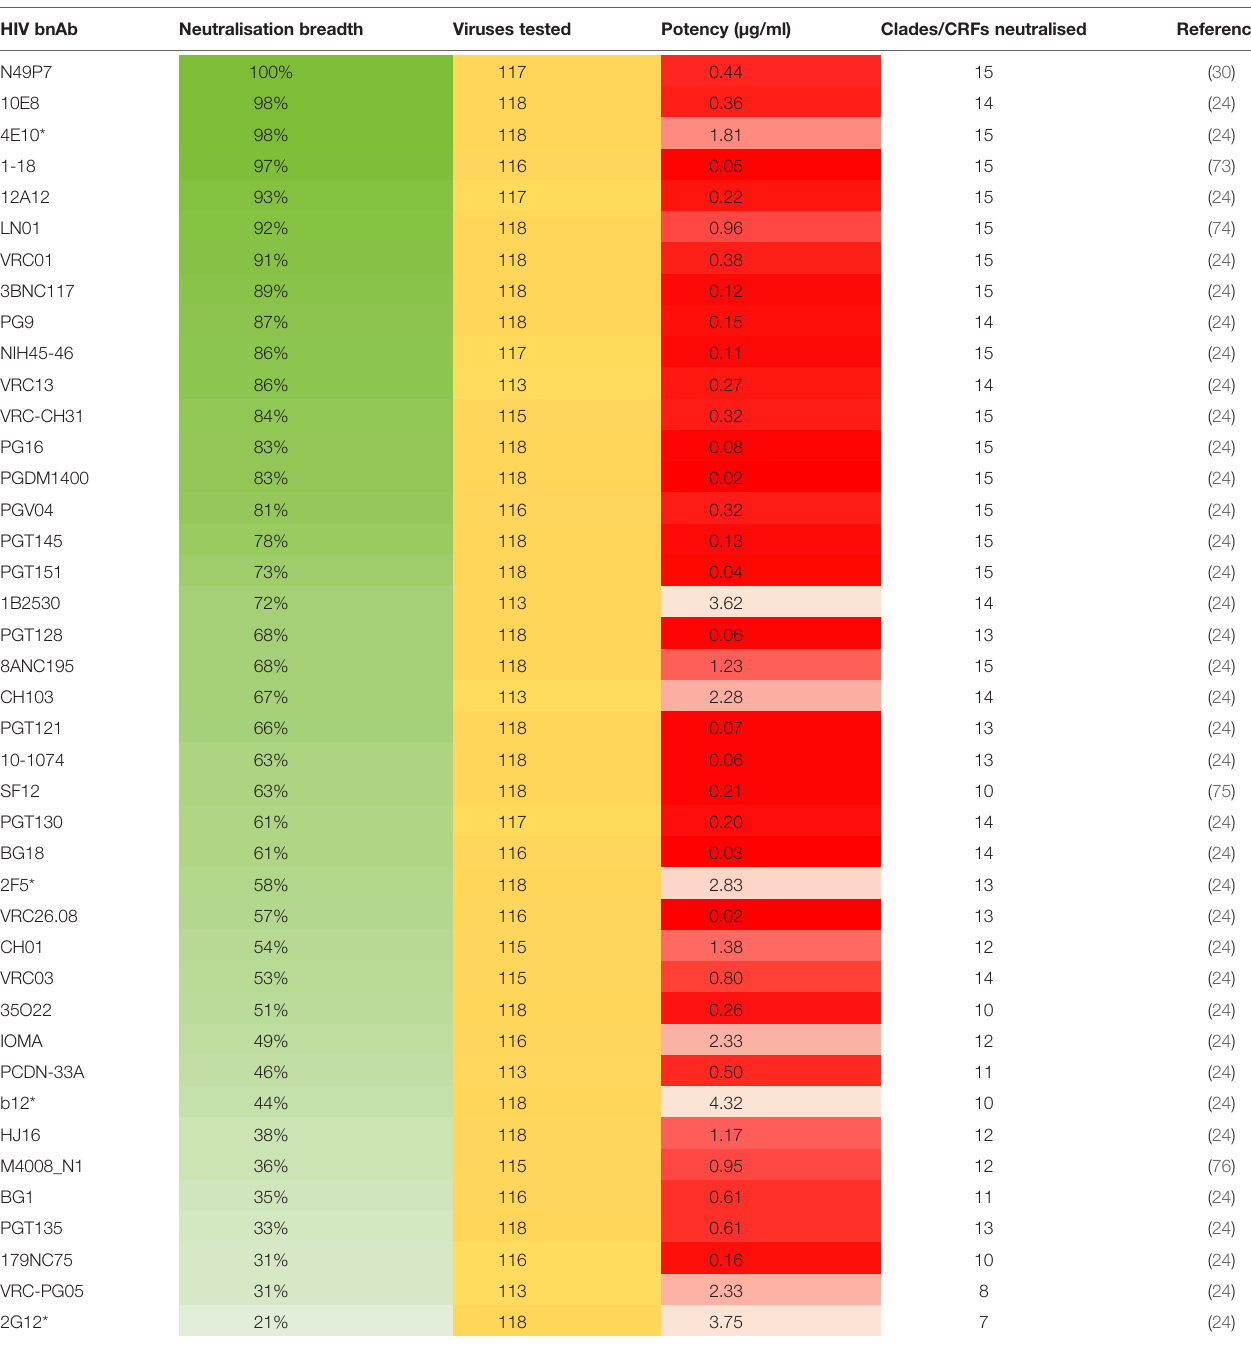
TABLE 1 | Comparison of bnAb breadth against the 118 multi-clade standard PV panel. HIV bnAb Neutralisation breadth Viruses tested Potency (µg/ml) Clades/CRFs neutralised